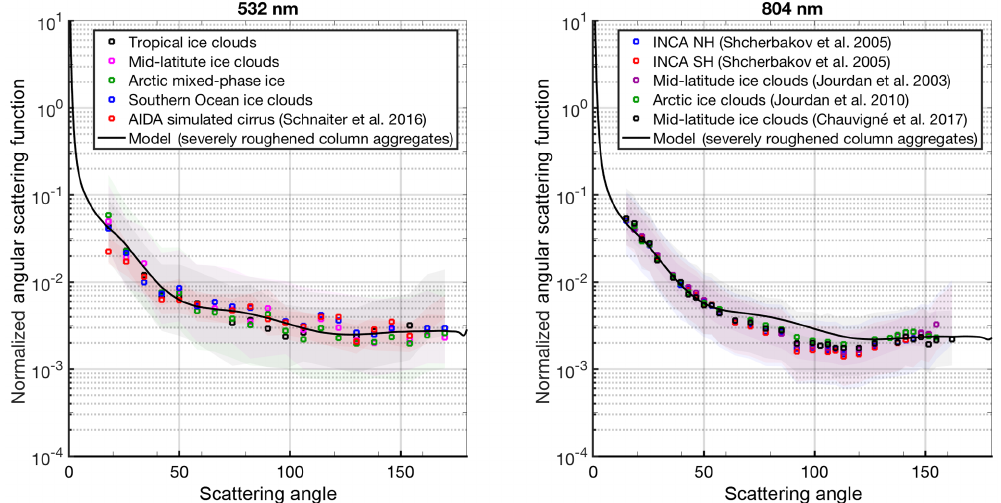
Figure 4. Ensemble angular scattering functions of natural and laboratory-generated ice particles measured at two wavelengths. Each function represents the median angular scattering function over a single campaign and is normalized to the total intensity between 18 and 170 ◦ . The shaded area represents the interquartile range. The measurements at 532nm in tropical cirrus, Arctic boundary layer stratocumulus clouds as well as the measurements in laboratory-simulated cirrus were gathered together with the complexity measurements in the ACRIDICON- CHUVA, ACLOUD and AIDA campaigns. The midlatitude and Southern Ocean measurements at 532 nm were taken during the ARISTO campaign in 2017 and during the SOCRATES campaign, respectively. The measurements at 804nm were taken between 1997 and 2011 in the CIRRUS’98, INCA, ASTAR and CONCERT aircraft